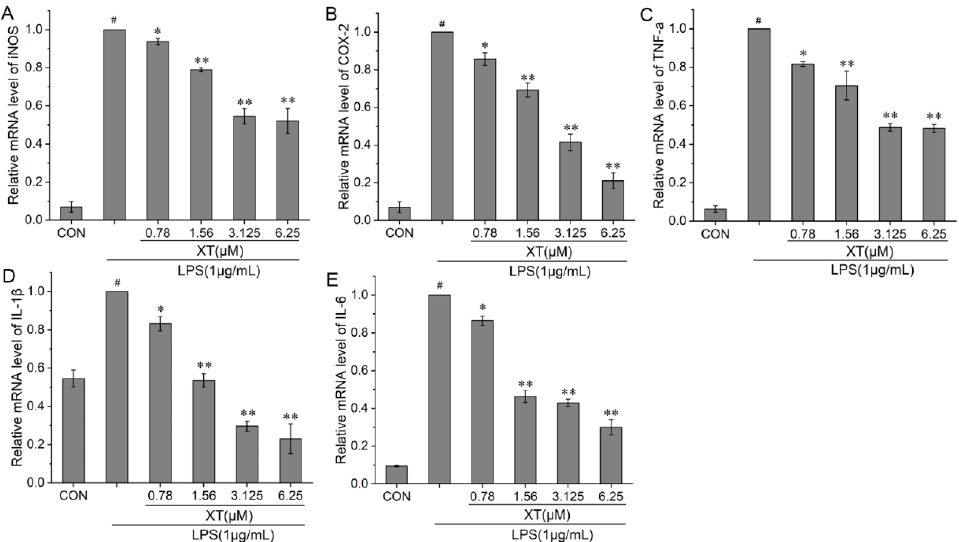
Figure 4. Effects of xanthatin on LPS − induced mRNA levels of iNOS ( A ), COX − 2 ( B ), TNF −α ( C ), IL − 1 β ( D ) and IL − 6 ( E ) in RAW 264.7 cells. When cells were pre − treated with xanthatin and activated by LPS, the mRNA levels of iNOS, COX − 2, TNF −α , IL − 1 β and IL − 6 was detected by qPCR. These results for the related mRNA expression levels were normalized with β− actin. Data is shown as means ± SDs (n = 3). #: significantly different compared to the control (CON) group, *: p < 0.05, **: p < 0.01, as compared to the LPS − induced group.